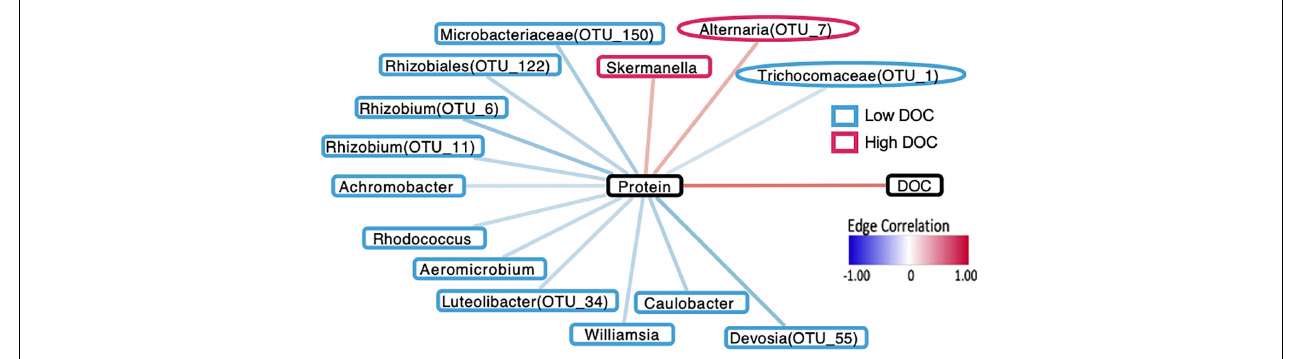
FIGURE 5 | Network diagram demonstrating that interactions between microbial taxa, proteins, and DOC are in accordance with the machine-learning assignments for microorganisms in terms of DOC concentration. Borders around taxa indicate whether they are associated with high DOC (red) or low DOC (blue). Bacterial taxa are indicated by rectangular borders and fungal taxa are indicated by oval borders. Black borders indicate DOC and protein